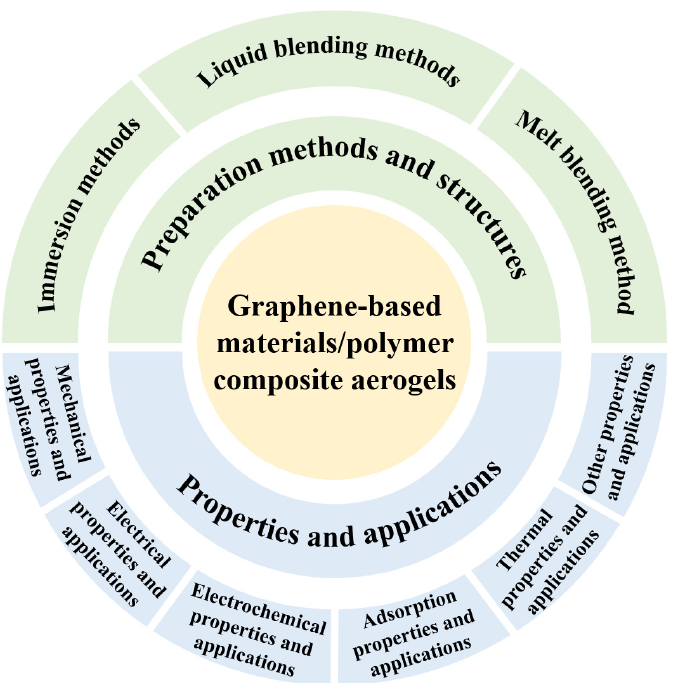
Figure 1. The guide map of this review on graphene-based materials/polymer composite aerogels.